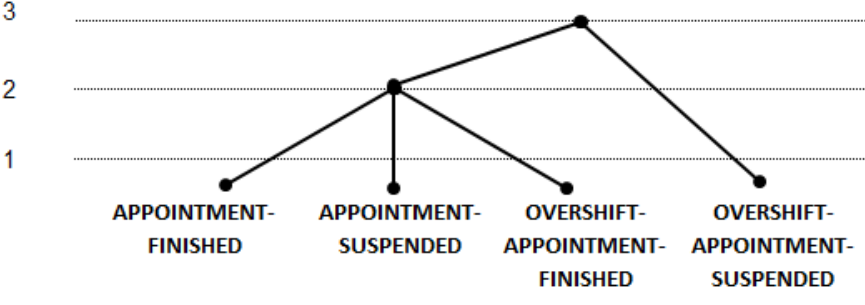
Figure 1: Ordered Tree of